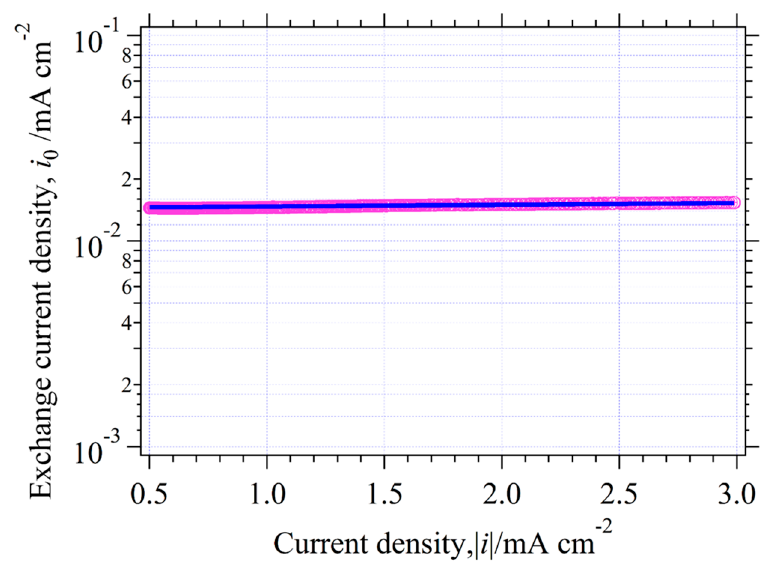
Figure 10. Relation between the (cid:1861) (cid:2868) calculated using Equation (37) and the values of 0.5 mA cm (cid:2879)(cid:2870) (cid:3409) |(cid:1861)| (cid:3409) 3 mA cm (cid:2879)(cid:2870) . We can see that the (cid:1861) (cid:2868) shows approximate value of 1.4 (cid:3400) 10 (cid:2879)(cid:2870) mA cm (cid:2879)(cid:2870) (cid:4666)(cid:3406) 10 (cid:2879)(cid:2869).(cid:2876) mA cm (cid:2879)(cid:2870) (cid:4667) .